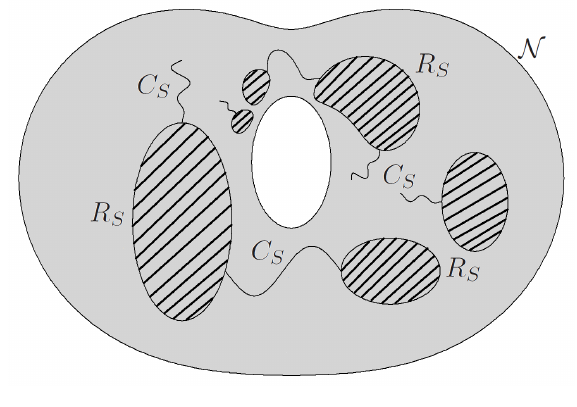
Fig. 1. An I -admissible set S ⊂ N